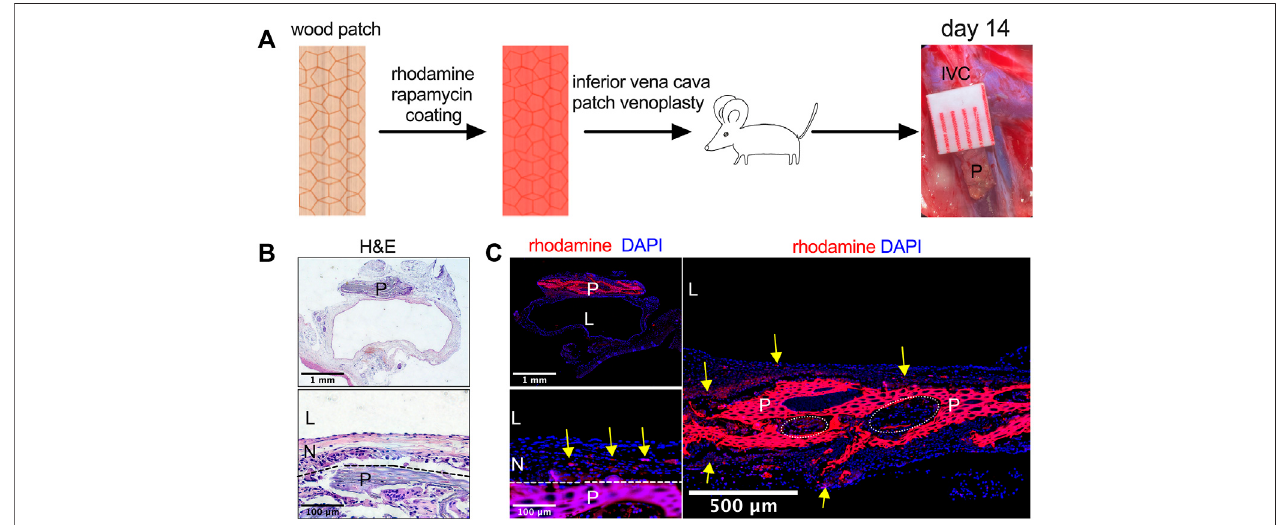
FIGURE 3 | Utility of rhodamine and rapamycin-coated wood patches as a drug delivery scaffold. (A) Experimental schema. IVC, inferior vena cava; P, patch. (B) Photographsofapatchstainedwithhematoxylinandeosin(H&E)onday14;P,patch;L,lumen;N,neointima; n =3;thedashedlineshowsdemarcationoftheneointima and the wood patch. (C) Immuno fl uorescence showing the rhodamine-conjugated wood patch harvested on day 14 after patch venoplasty, P, patch; L, lumen; N, neointima; scale bar, 1 mm or 100 μ m or 500 μ m; yellow arrow shows the rhodamine fl uorescence; n = 3; cell in fi ltration into the wood patch denoted by the dashed line circles should be noted.